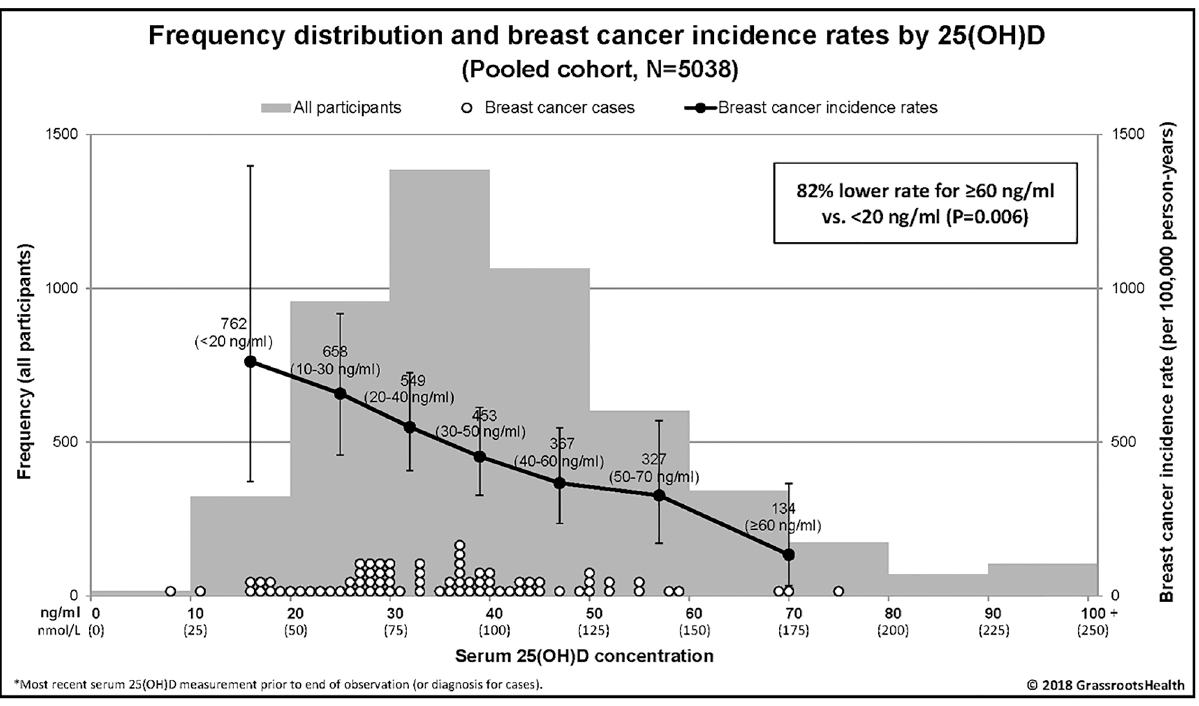
Fig 1. Frequency distribution and breast cancer incidence rates by 25(OH)D concentration, pooled cohort (N = 5038). The bars represent the number of participants by groupings of 10 ng/ml (left y-axis), white dots represent the 25(OH)D concentration for each breast cancer case, black dots represent breast cancer incidence rates per 100,000 person-years for each 25(OH)D group (plotted at the median value for each group: 16, 25, 32, 39, 47, 57, and 70 ng/ml) (right y-axis). Vertical error bars represent the 95% confidence intervals.